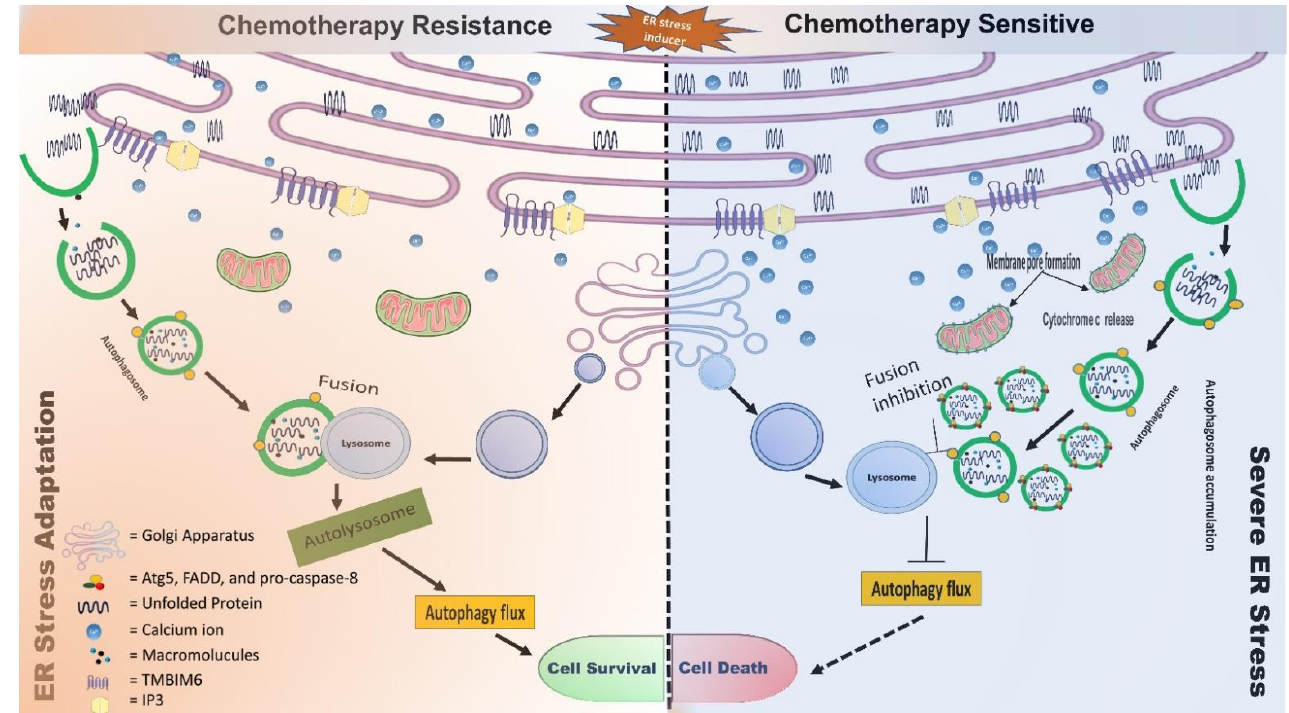
Figure 3. Schematic illustration of the effect of chemotherapy on cell fate during adaptation and severe ER stress conditions. Chemotherapy activates ER stress-mediated autophagy, which activates a protective mechanism for cancer cells during chemotherapy. On the other hand, autophagy inhibition executes apoptosis through multiple pathways, such as mitochondrial apoptosis, UPR, and autophagosomal apoptosis. Autophagosome accumulation in cytosol increases ER stress. Ad- ditionally, chronic ER stress increases mitochondrial Ca 2+ imbalance, which ruptures the mitochon- drial membrane; activates Bax, Bak, and caspase 9; and releases cytochrome c-mediated cell death. Table 3. Autophagy inhibitors intersecting with ER stress.